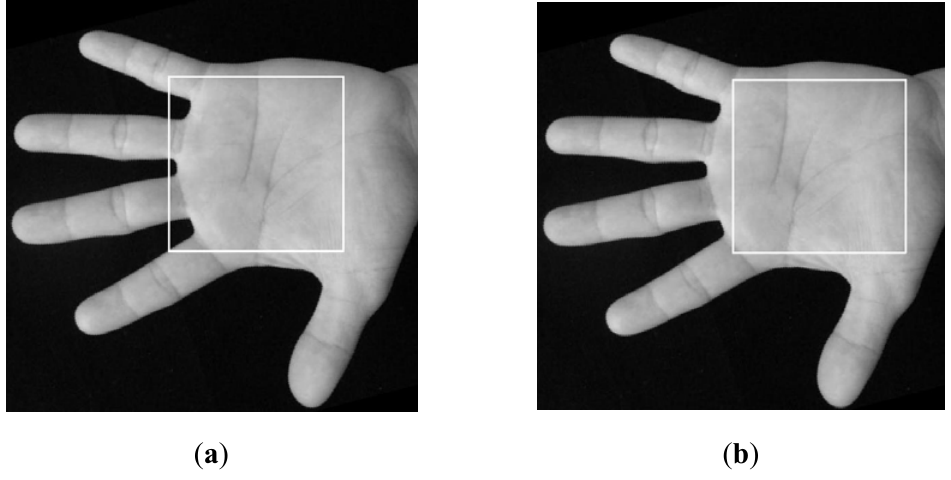
Figure 8. Crop the ROI sub-image before ( a ) and after ( b ) moving the position of center point.